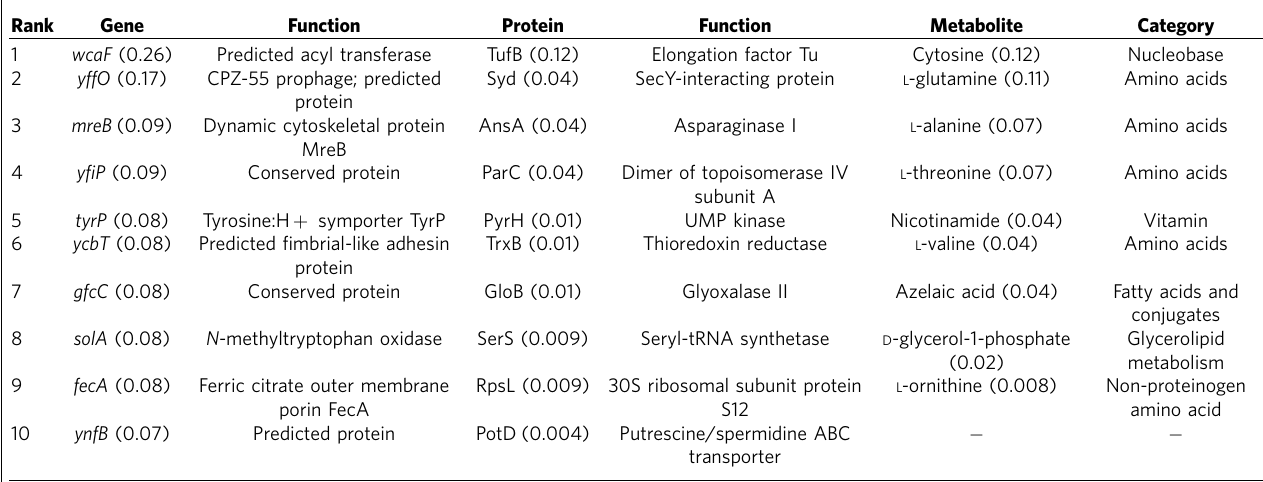
Table 1 | The top 10 informative features to predict growth rate for each of the three